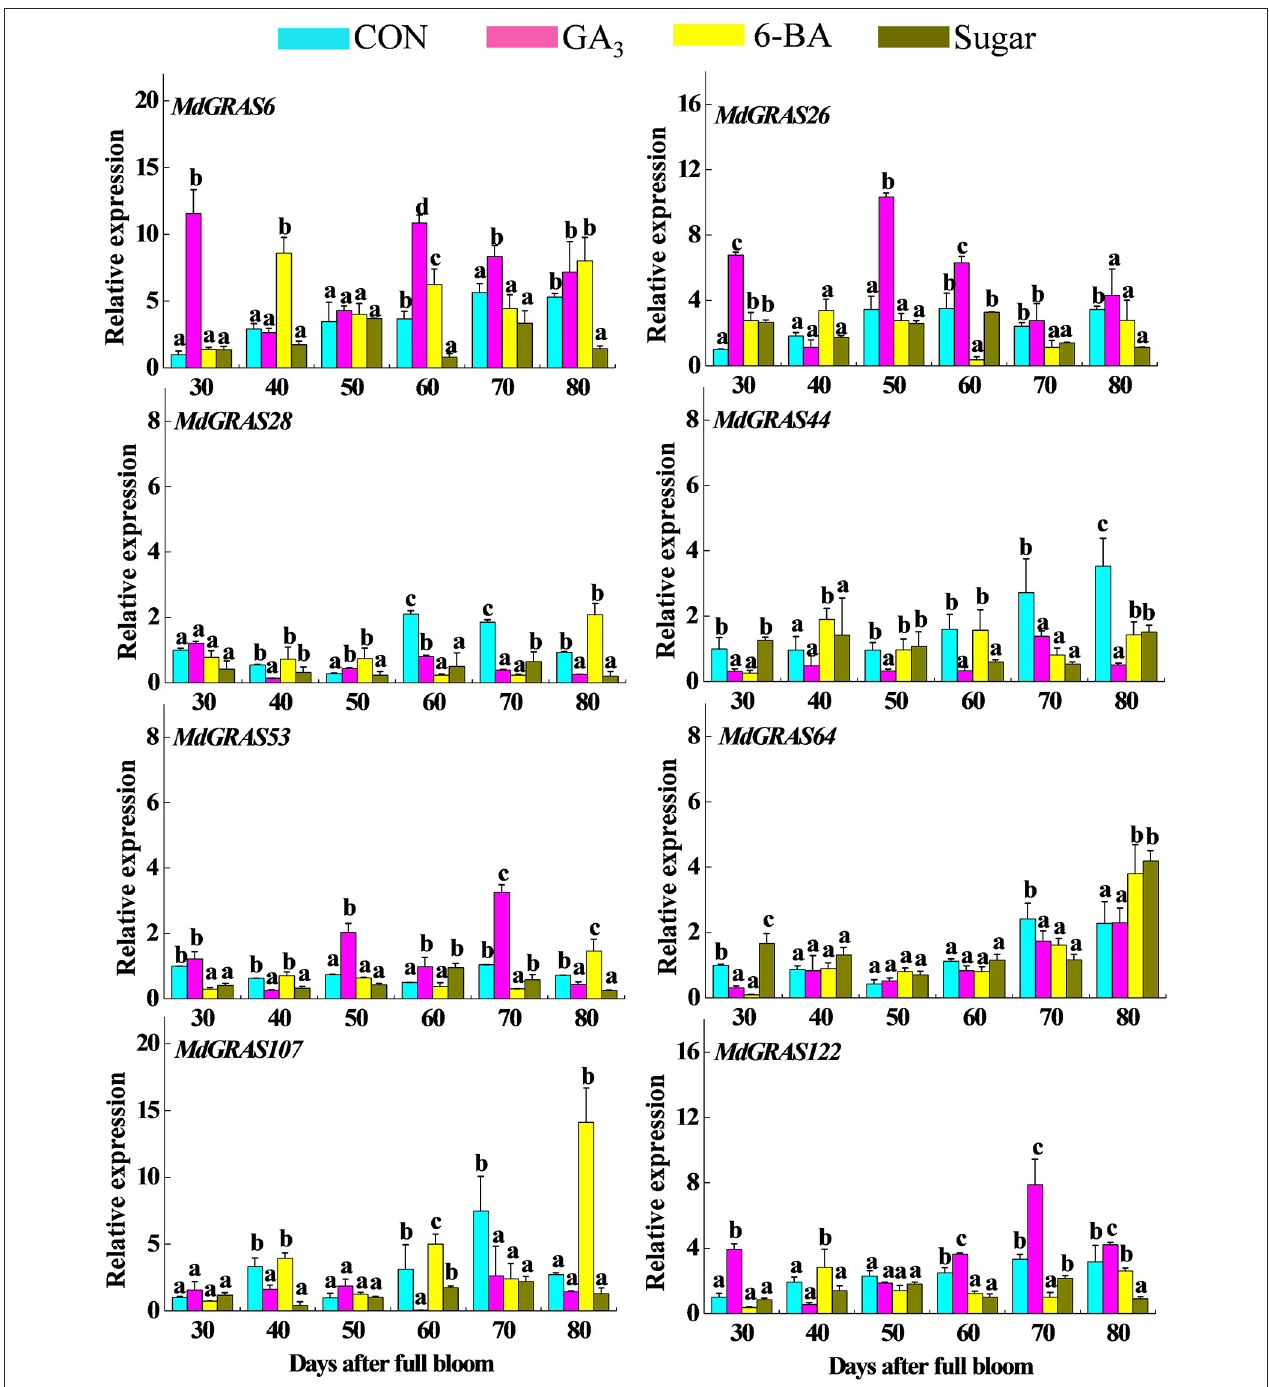
FIGURE 8 | Expression of candidate MdGRAS genes in apple buds treated with GA 3 , 6-BA, and sugar. Samples were collected at 30, 40, 50, 60, 70, and 80 days after full bloom (DAFB). Each value represents the mean ± standard error of three replicates. Means followed by small letters (a, b, and c) are significantly different at a level of